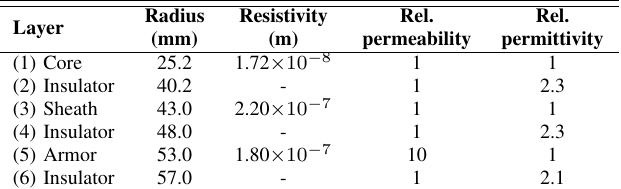
TABLE III DC C ABLE D ATA